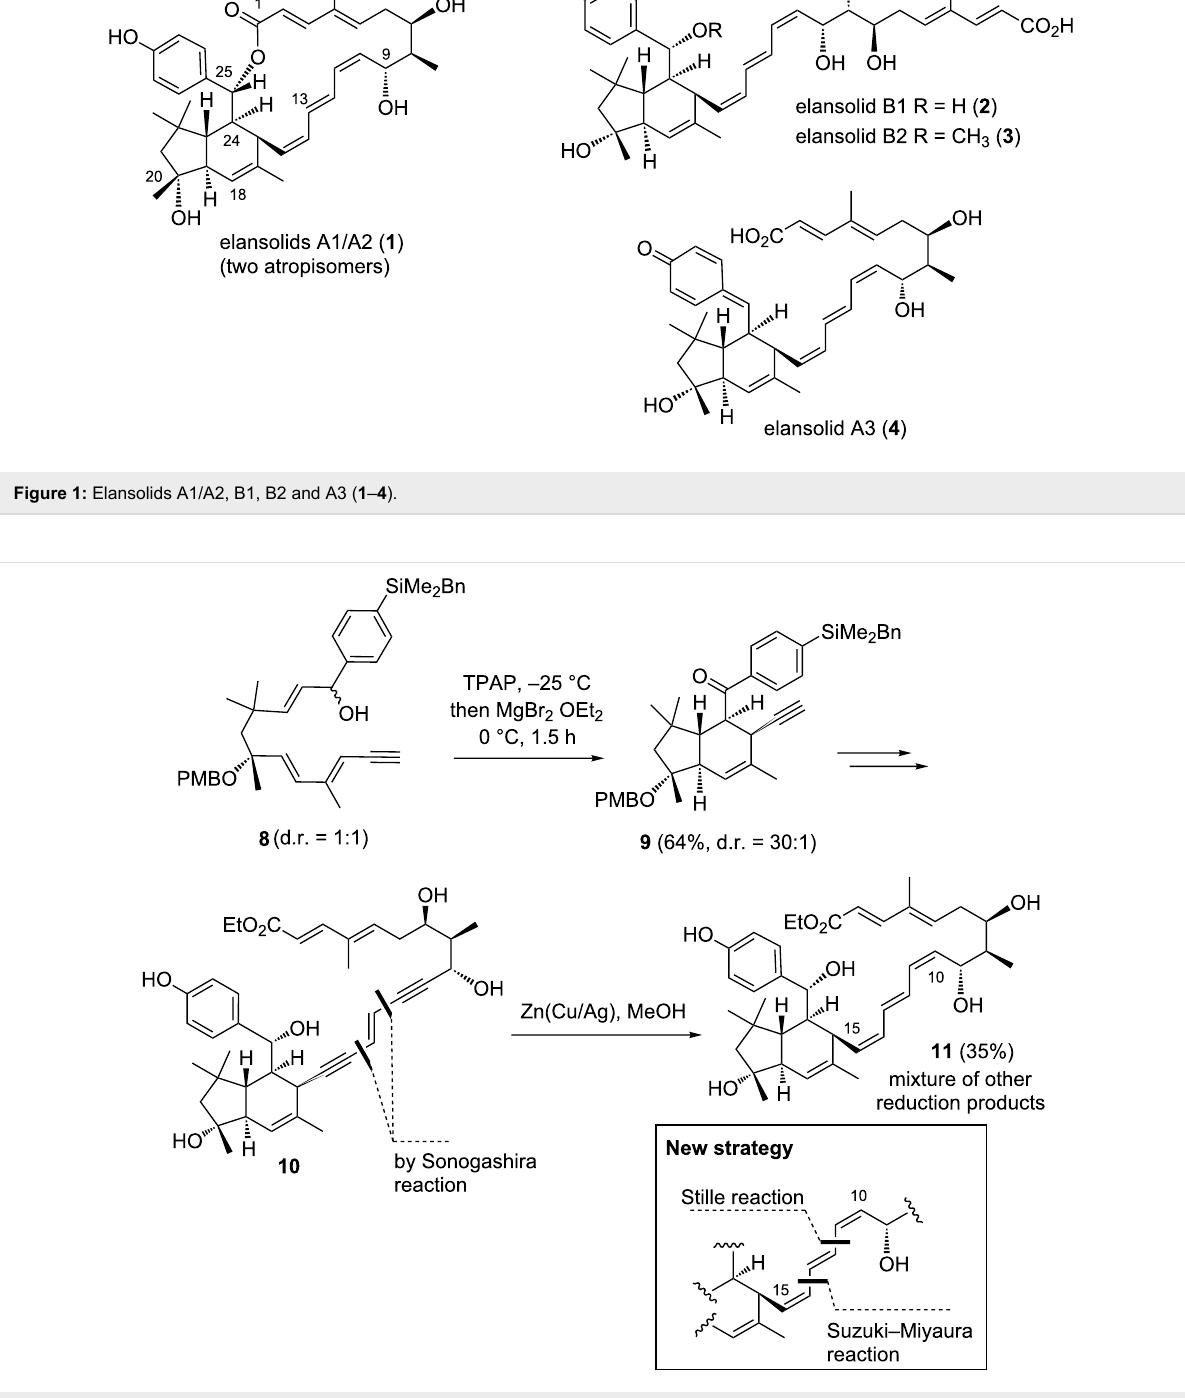
Scheme 1: IMDA to generate the tetrahydroindane unit of the elansolids by oxidation of benzyl ether 8 as precursor and construction of the ( Z,E,Z )- triene unit at C10–C15 (TPAP = tetra- n -propylammonium perruthenate(VII); PMB = p -methoxybenzyl; Bn = benzyl).